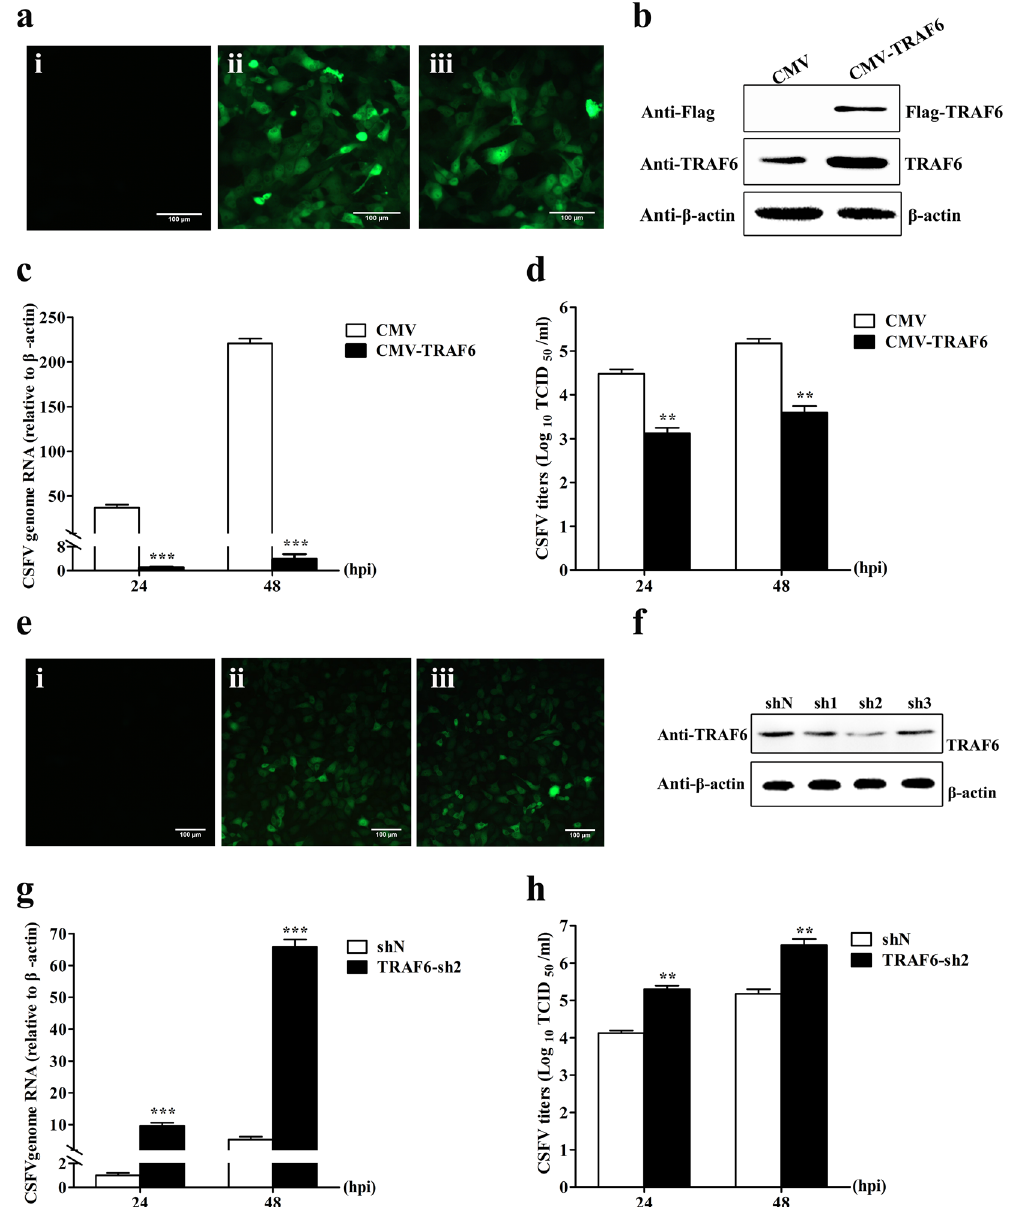
Figure 2. TRAF6 inhibits CSFV replication. PAMs stably overexpressing TRAF6 and knockdown of TRAF6 were constructed via lentivirus. ( a ) Confirmation of CMV-TRAF6 recombinant lentivirus infection by fluorescence detection of the GFP reporter expressed in PAMs. (i) Mock-infected PAMs. (ii) PAMs infected with lentiviruses expressing CMV. (iii) PAMs infected with lentiviruses expressing CMV-TRAF6. ( b ) Western blot for TRAF6 expression in stable CMV-TRAF6 cells. β -actin was used as an internal control. ( c ) CSFV genome RNA in TRAF6-overexpressing cells. Cells stably expressing CMV or CMV-TRAF6 were infected with CSFV. RT-PCR determined CSFV genome RNA levels at 24 and 48 hpi. ( d ) Infectious progeny viral titres in supernatants from TRAF6-overexpressing cells. Viral titres from the supernatant collected at 24 and 48 hpi were determined and expressed as TCID 50 /ml. ( e ) Confirmation of TRAF6-knockdown lentivirus infection by fluorescence detection of the GFP reporter expressed in PAMs. (i) Mock-infected PAMs. (ii) PAMs infected with lentiviruses expressing shN. (iii) PAMs infected with TRAF6-knockdown lentivirus. ( f ) Western blot for TRAF6 expression in TRAF6 knockdown cells. Cells stably expressing TRAF6-sh1, TRAF6-sh2, TRAF6-sh3, or shN were constructed, and Western blot determined endogenous TRAF6 expression. ( g ) CSFV genome RNA in TRAF6-sh2 cells. Stable shN and TRAF6-sh2 cells were infected with CSFV, and RT-PCR determined CSFV genome RNA levels at 24 and 48 hpi. ( h ) Viral titres of infectious progeny in supernatant from TRAF6-sh2 cells. Viral titres from the supernatant collected at 24 and 48 hpi were determined and expressed as TCID 50 /ml. Error bars represent the mean ± SD of three independent experiments. ** P < 0.01 and *** P < 0.001 compared with the controls calculated using Student’s t-test